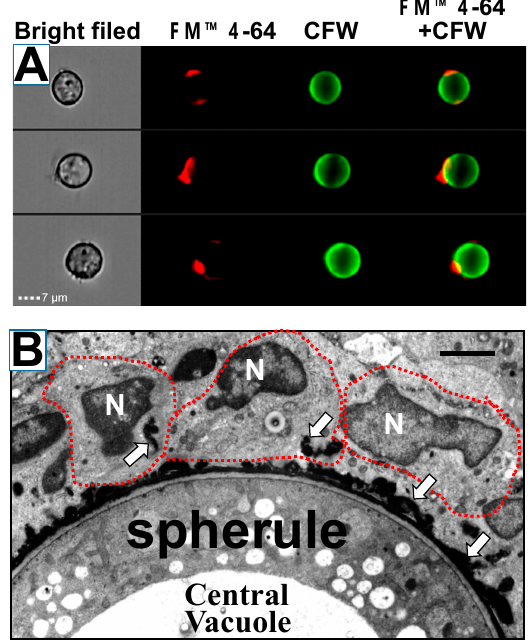
Figure 10. Images in triplicate of spherules ( A ) labeled with calcofluor white (CFW) and FM ™ 4-64FX, a lipophilic dye (red) in vitro. SOW lipids are enriched in the inner leaflet of SOW. When the lipid is exposed as the SOW separates from the surface it binds to FM ™ 4-64FX dye [135]. Electron microscopy image ( B ) of a histological section of C. posadasii -infected tissue from the mouse lungs. Tissue section was labeled with osmium tetroxide (OsO4) to enhance the visibility of lipids. Host phagocytes are outlined with red dash-dot lines and their nuclei are labeled (N). Lipid-rich SOW fragments are visible inside phagocytes (white arrows). The bar is 5 µ M. Image courtesy of Dr. Garry Cole and Dr. Kalpathi R. Seshan.